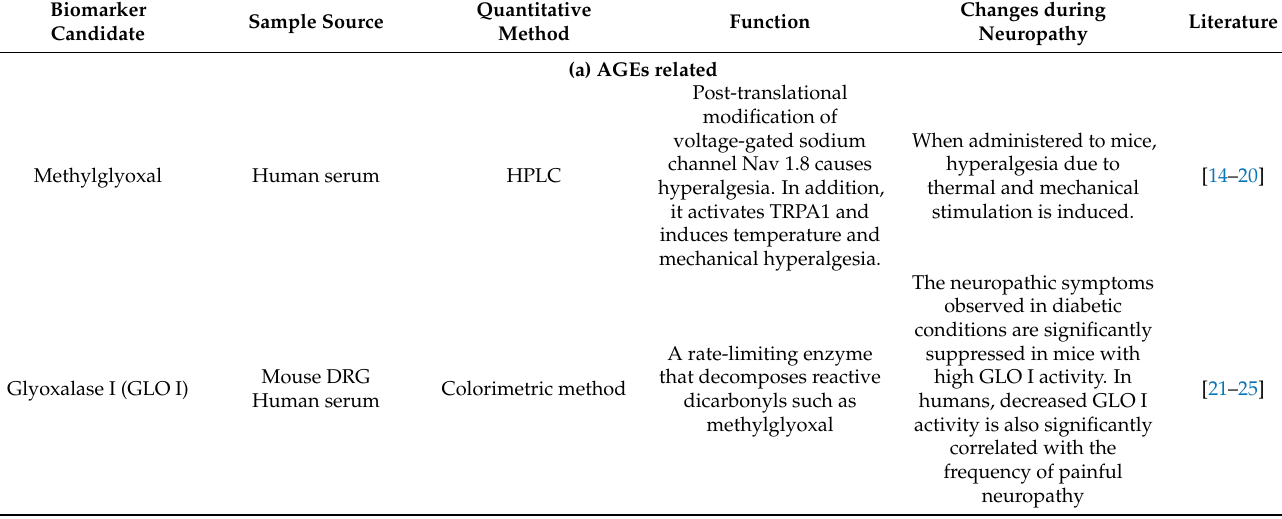
Table 1. Biomarkers for diabetic neuropathy mentioned in this